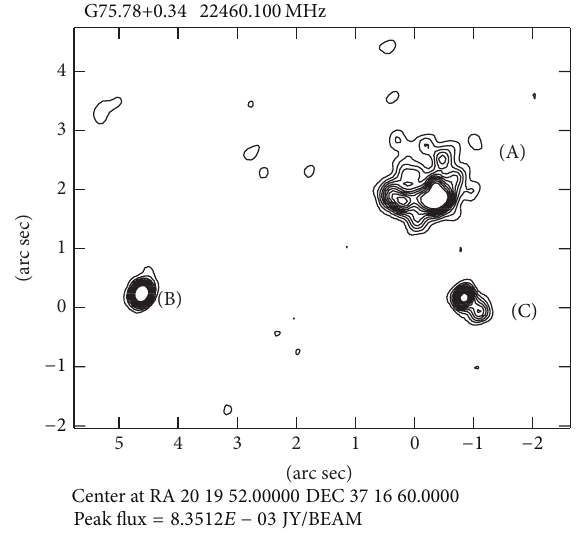
Figure 1: 1.3cm radio continuum image of G75.78+0.34 obtained with VLA at “A” configuration. Flux levels are 0.5, 1.0, 1.5, 2.0, 2.5, 3.0, 3.5, 4.0, 4.5, and 5.0 mJy/beam.